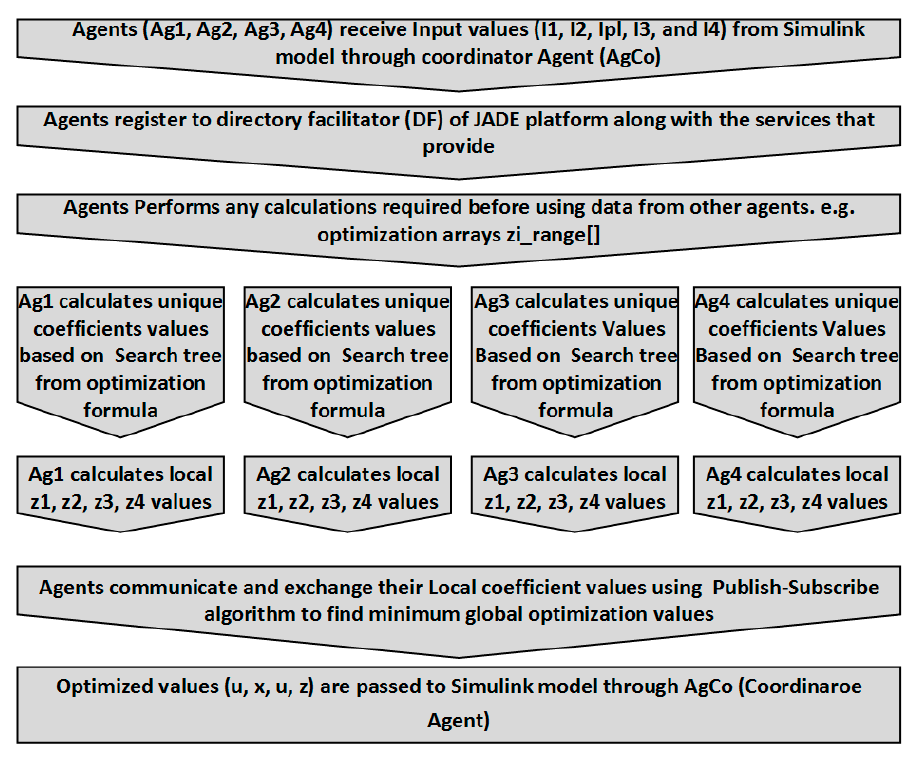
Figure 8. The flow of optimization variables in MAS (Multi-agent System).